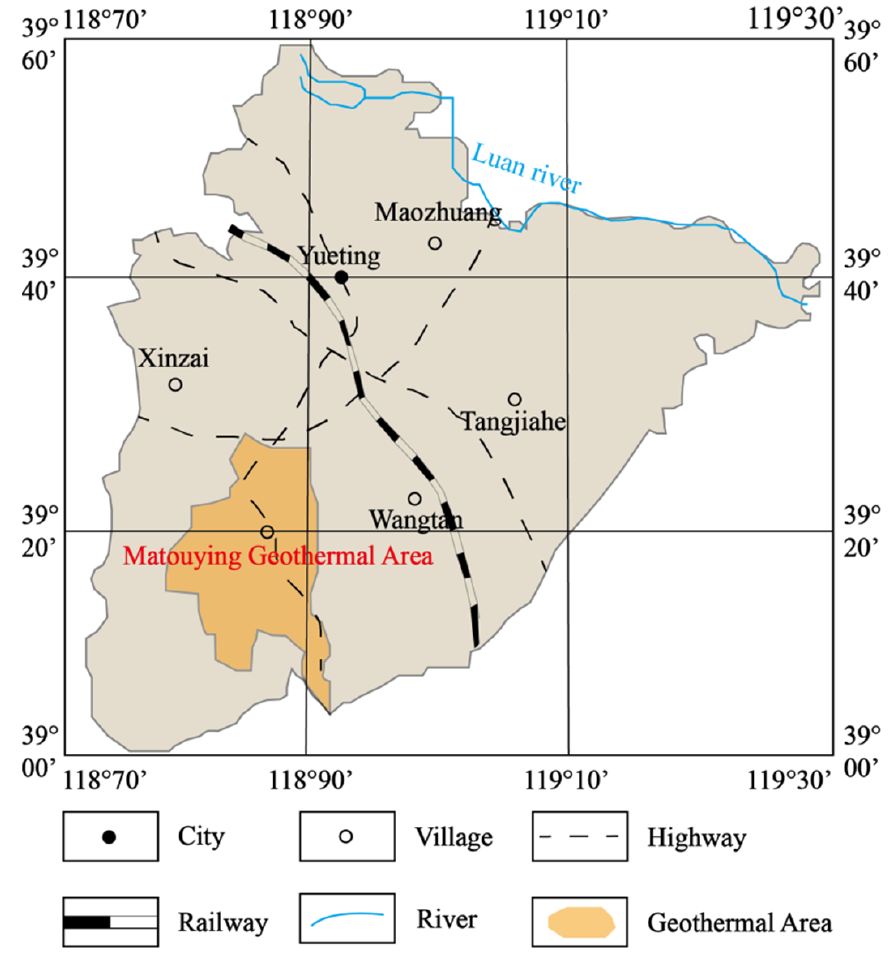
Figure 1. Matouying geothermal field location.